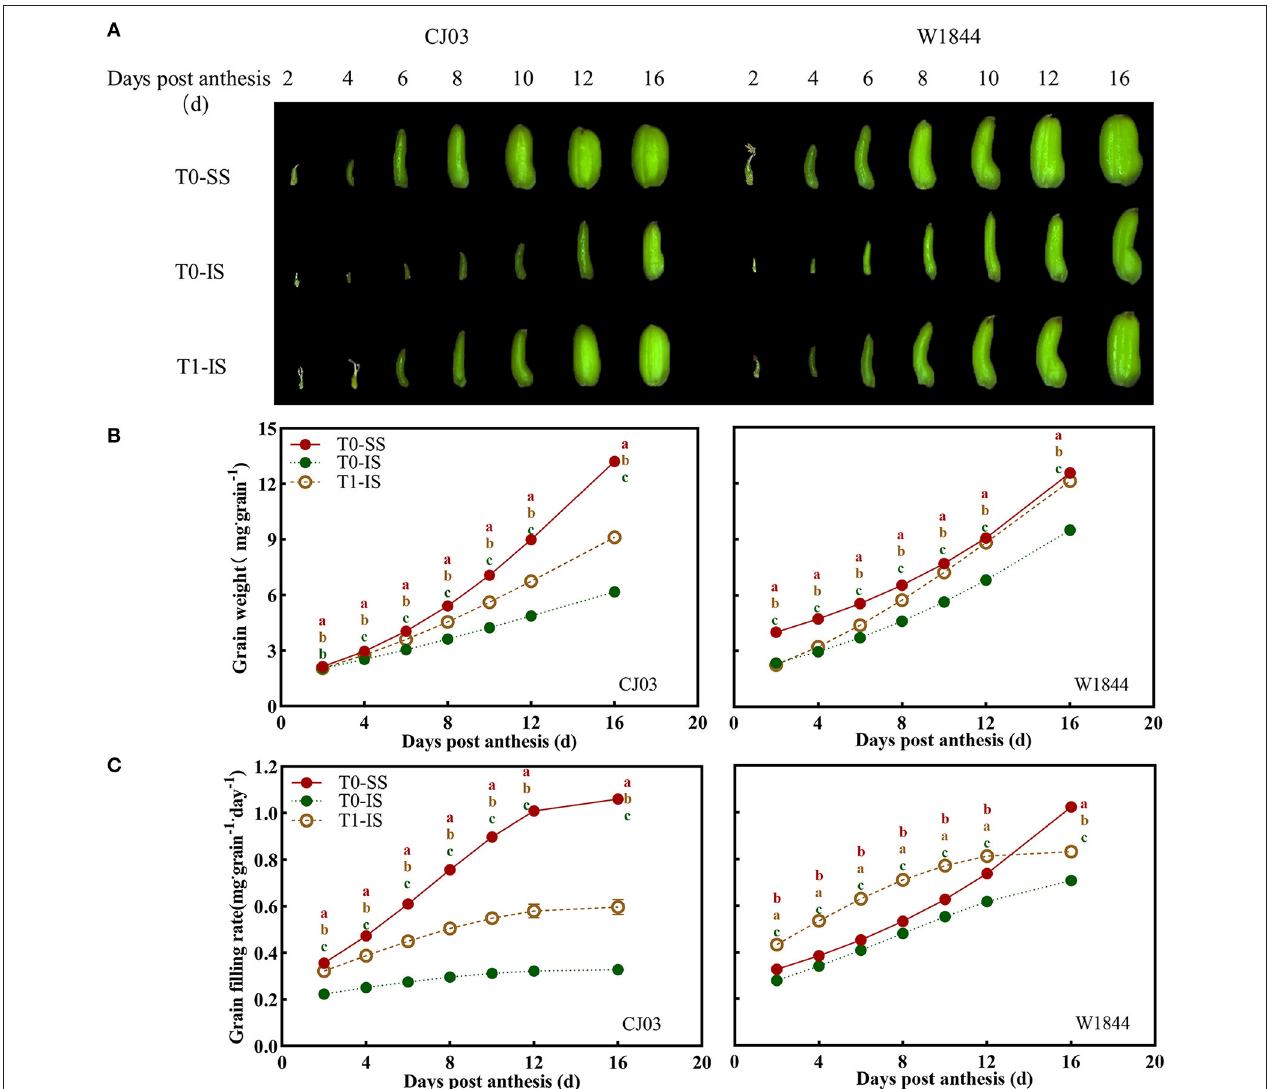
FIGURE 2 | Dynamic of grain growth in CJ03 and W1844 during early grain filling period under spikelet-removing treatments. The T0 and T1 represent the control group without any treatment and the top 2/3 of the spikelets were removed. (A) , the morphology of SS and IS in rice during the early grain filling period (observed under stereoscope). (B) , the changes of grain weight in the test materials during the early grain filling period under spikelet-removing treatments. (C) , changes of grain filling rate in the test materials during early grain filling period under spikelet-removing treatments. Colored letters indicate statistically significant differences between treatments of the same day at the P = 0.05